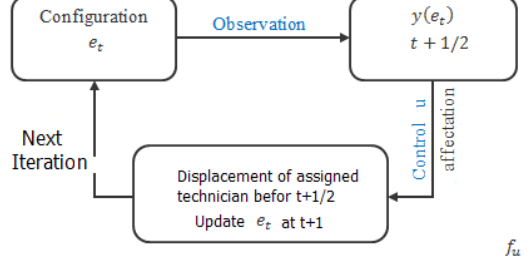
Figure 3. Principle of feedback control for maintenance